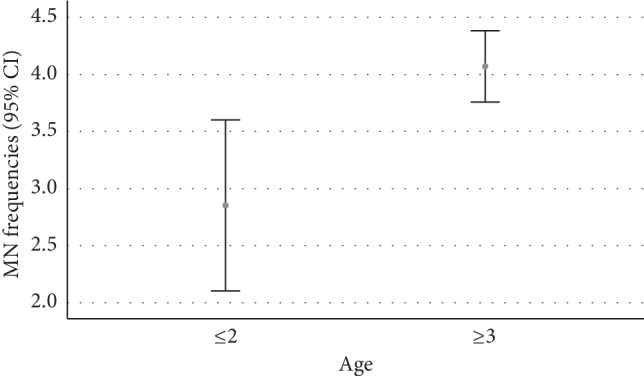
Error bar chart reveals the MN frequencies of 0–2 years age group and 3–15 years age group. There is a significant association of MN frequencies between these 2 groups (95% confidence interval) (MN: micronucleus, CI: confidence interval).